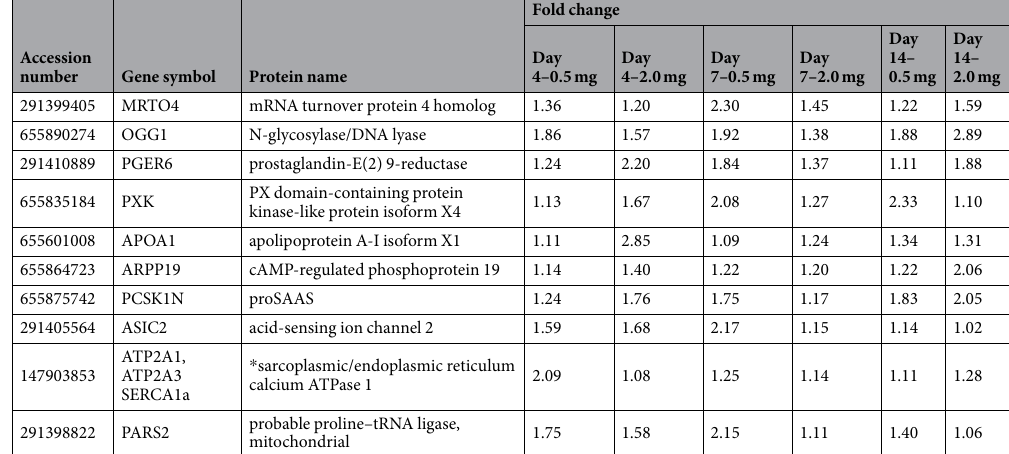
Table 1. Significantly up-regulated proteins after intravitreal injection of conbercept. * Means the proteins are not predicted